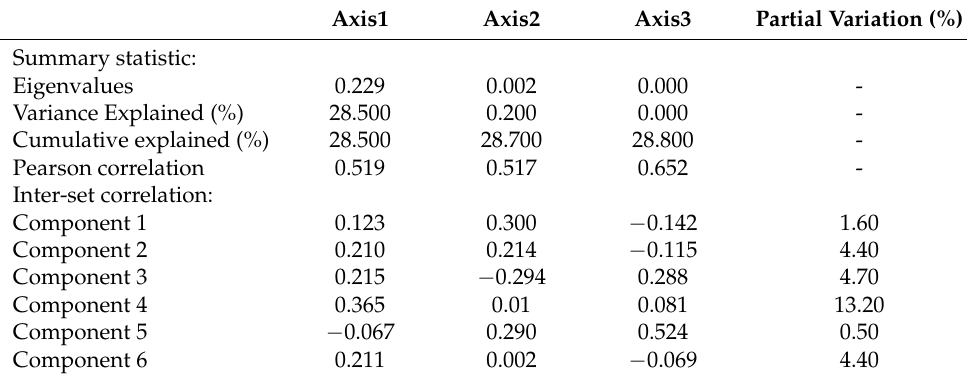
Table 5. Summary Statistics of Redundancy Analysis (RDA) between tree vegetation communities and environmental